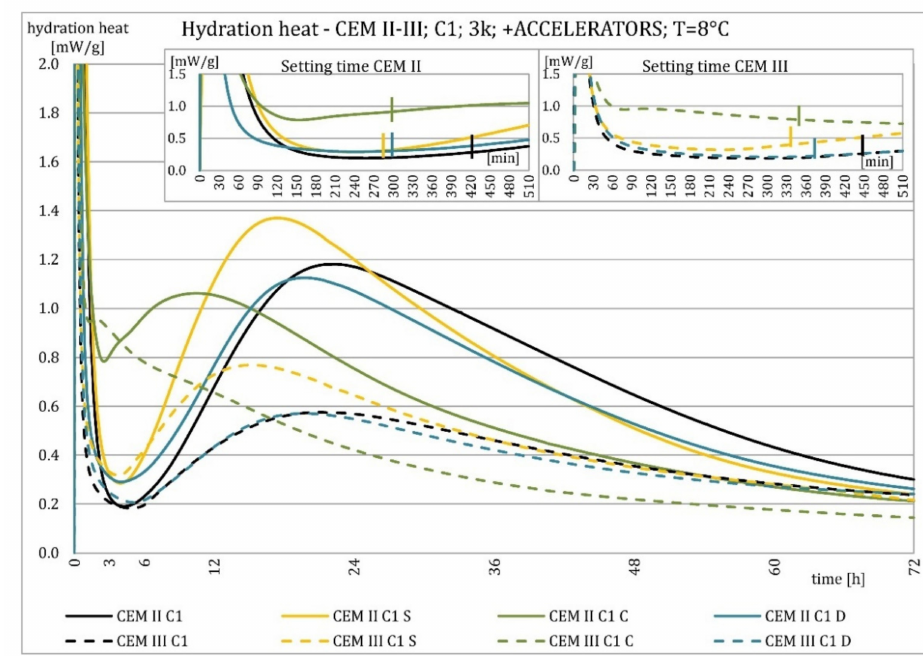
Figure 26. Hydration heat of C1 clinker-based cements CEM II/B-S, CEM III/A modified with accelerators at 8 ◦ C.